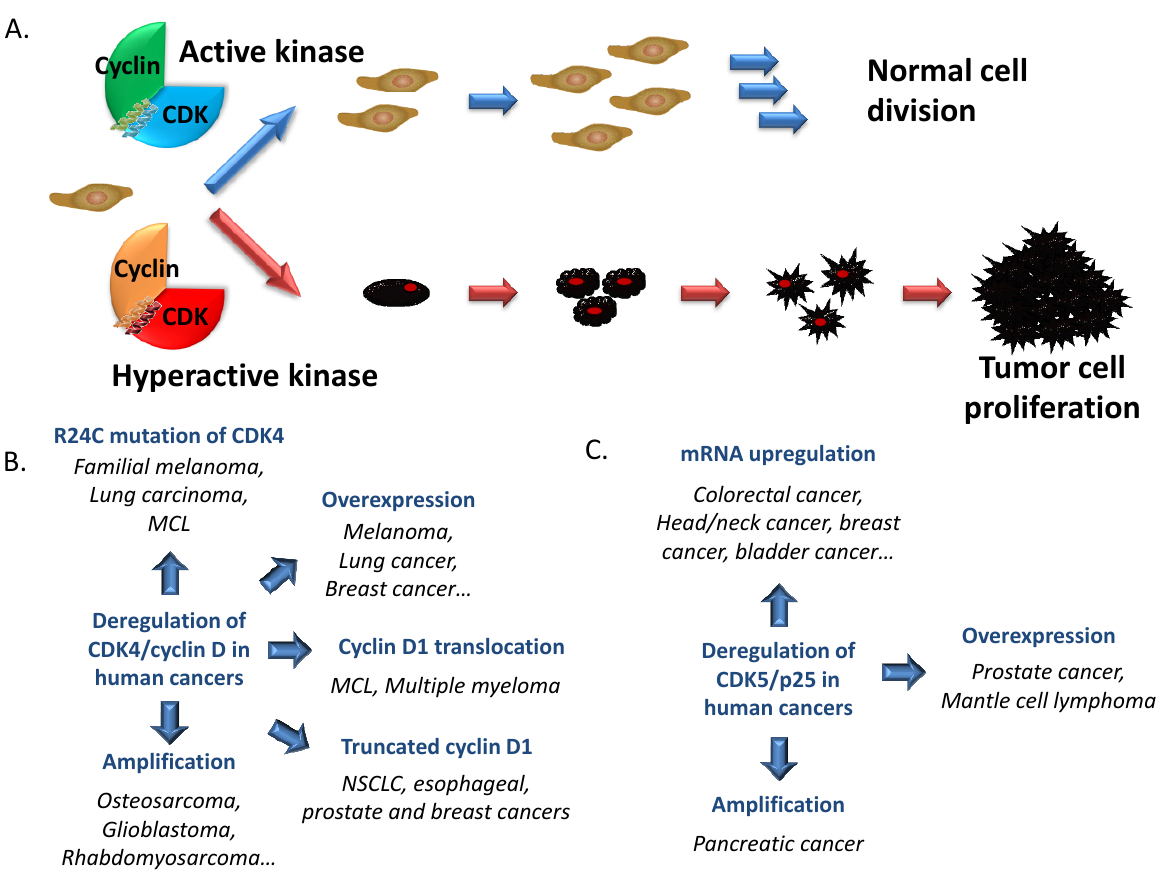
Figure 4. CDK/Cyclins and Cancer. ( A ) Schematic representation of normal cell growth and division regulated by cyclin-dependent kinases. Hyperactivation of these kinases contributes to development of cancer cell proliferation; ( B ) CDK4/cyclin D in cancers: Among all the CDK/cyclins, the complex CDK4/cyclin D is the one which presents most aberrations in cancers. Hyperactive CDK4/cyclin D is found in several human cancers associated with the R24C mutation of CDK4 which prevents the fixation of the endogenous inhibitor p16 INK4A , mutation of p16 INK4a itself or CDK4 or cyclin D amplification; ( C ) CDK5/p25 in